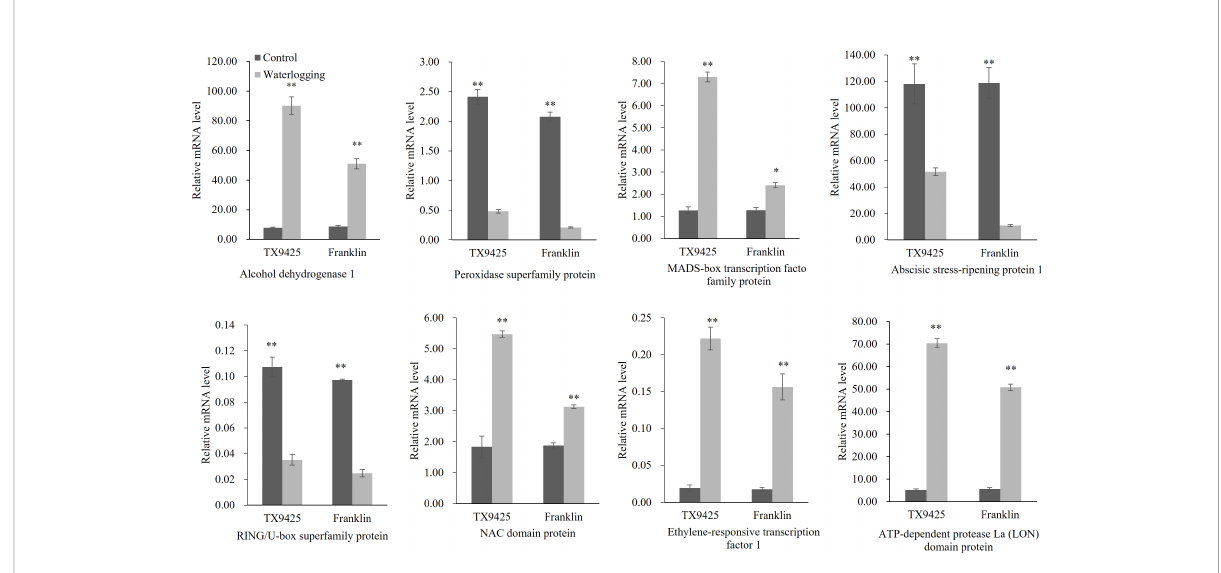
FIGURE 5 qRT-PCR analysis of eight candidate genes associated with the waterlogging tolerance in barley. “ * ” means a signi fi cant difference at the P < 0.05 level, “ ** ” means a signi fi cant difference at the P < 0.01